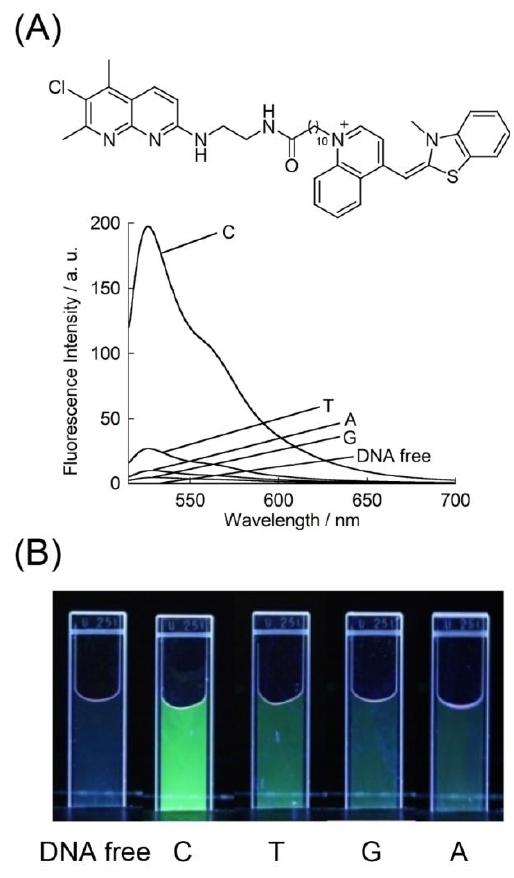
Figure 3. ( A ) Fluorescence response of ClNaph–TO conjugate (500 nM) to target AP–DNA duplexes (500 nM). Excitation, 504 nm. Temperature, 20 ◦ C. ( B ) Images of fluorescence emission of ClNaph–TO conjugate (500 nM) in the absence and presence of target AP–DNA duplexes (500 nM) under excitation light with the wavelength of 365 nm, obtained by a digital camera at room temperature. Other solution conditions are the same as those given in Figure